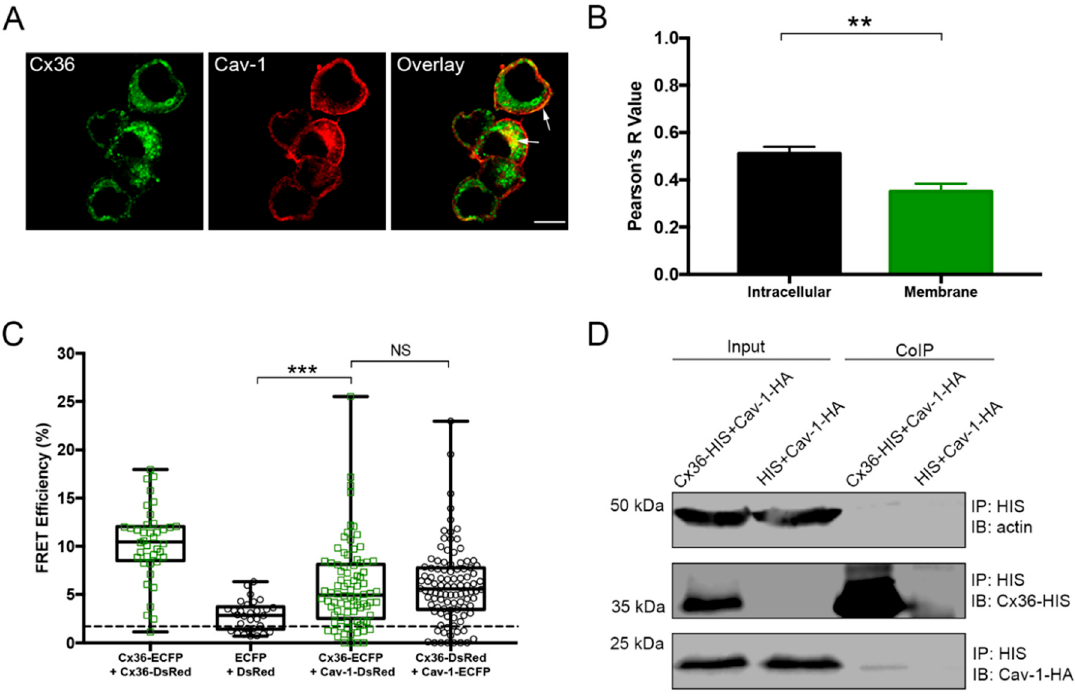
Figure 1. Co-localization, Förster Resonance Energy Transfer Analysis (FRET), and coimmunoprecipitation (CoIP) analysis of Cx36 and Cav-1. ( A ) Neuro 2a cells transfected with Cx36-HIS and Cav-1-HA were labeled with anti-HIS and anti-HA antibodies. Cx36 and Cav-1 displayed co-localization in the intracellular compartments and partly at the membrane (white arrows). Scale bar: 10 µ m. ( B ) Co-localization quantification of the Cx36-HIS and Cav-1-HA intracellularly and at the membrane. Error bars show standard error of the mean. Sample sizes were the following: Intracellular: n = 27; Membrane: n = 27. ( C ) FRET e ffi ciencies. Cx36-ECFP and Cx36-DsRed pair served as positive control while ECFP and DsRed pair served as a negative control. Cx36-ECFP and Cav-1-DsRed pair showed high FRET e ffi ciency, signifying that two proteins are close to one another. The exchange of tags on both proteins (Cx36-DsRed and Cav-1-ECFP) had no significant e ff ect on FRET e ffi ciency. The dotted line represents the threshold of 1.7% (equals to 10 nm distance between FRET pairs). Error bars show the minimum and maximum values. Sample sizes were the following: Cx36-ECFP + Cx36-DsRed: n = 40; ECFP + DsRed: n = 30; Cx36-ECFP + Cav-1-DsRed: n = 86; Cx36-DsRed + Cav-1-ECFP: n = 100. ( D ) CoIP of Cx36 and Cav-1. HIS antibody was used to pull down the Cx36-HIS and Cav-1-HA complex. Neuro 2a cells double transfected with HIS and Cav-1-HA served as a negative control. Input lanes (cell lysates) show protein levels prior to the assay. CoIP lanes represent eluted protein complexes. A low amount of Cav-1 eluted together with Cx36 signified weak or transient interaction. Anti-HA and anti-HIS antibodies detected Cav-1 and Cx36 proteins, respectively. An anti-ß-actin antibody served as a loading control. IP: immunoprecipitation; IB: immunoblotting. ** p < 0.01, *** p < 0.001, NS—not significant.